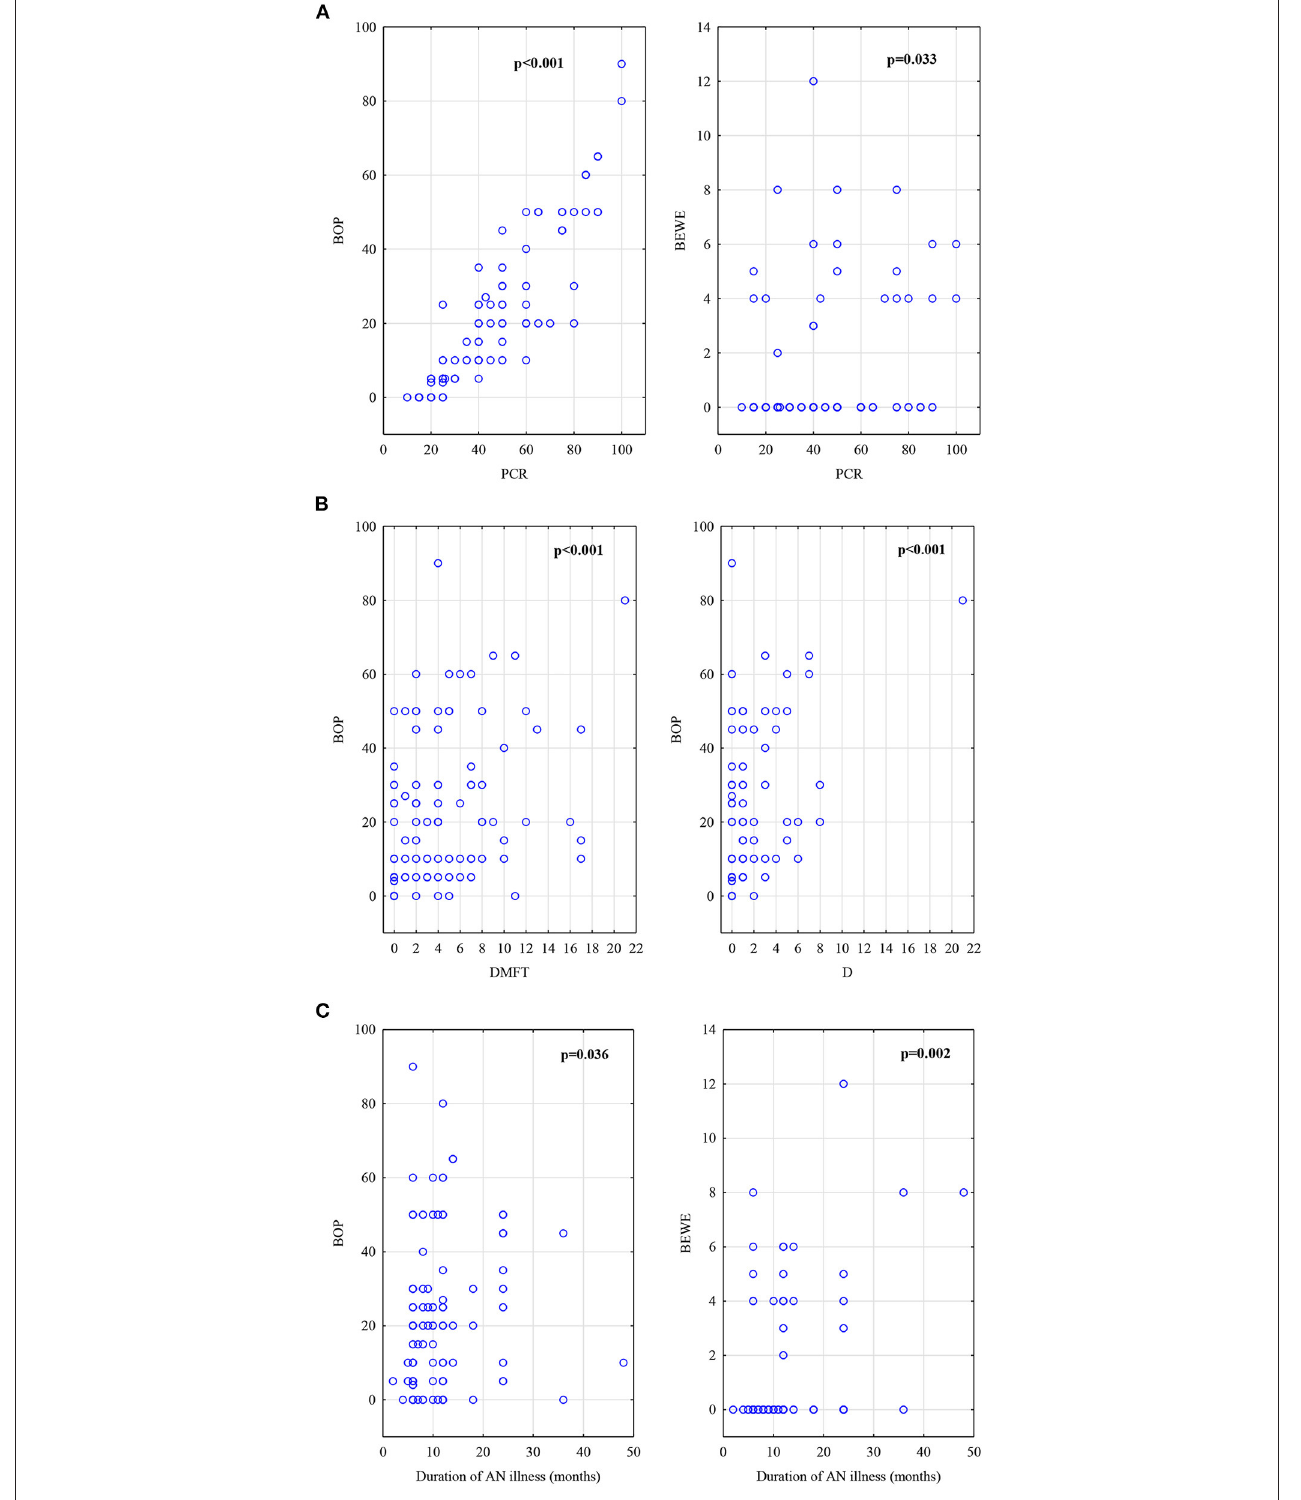
FIGURE 2 | (A) Correlations in AN group, BOP index and BEWE index to PCR index. (B) Correlations in AN group, DMFT score and D number to BOP index. (C) Correlations in AN group, BOP index and BEWE index to duration of AN illness (counted in months).